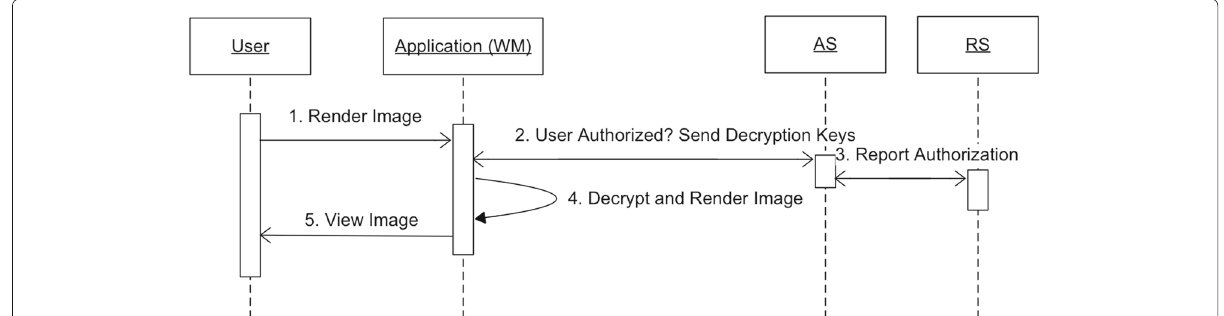
Fig. 8 Authorization of access to a protected